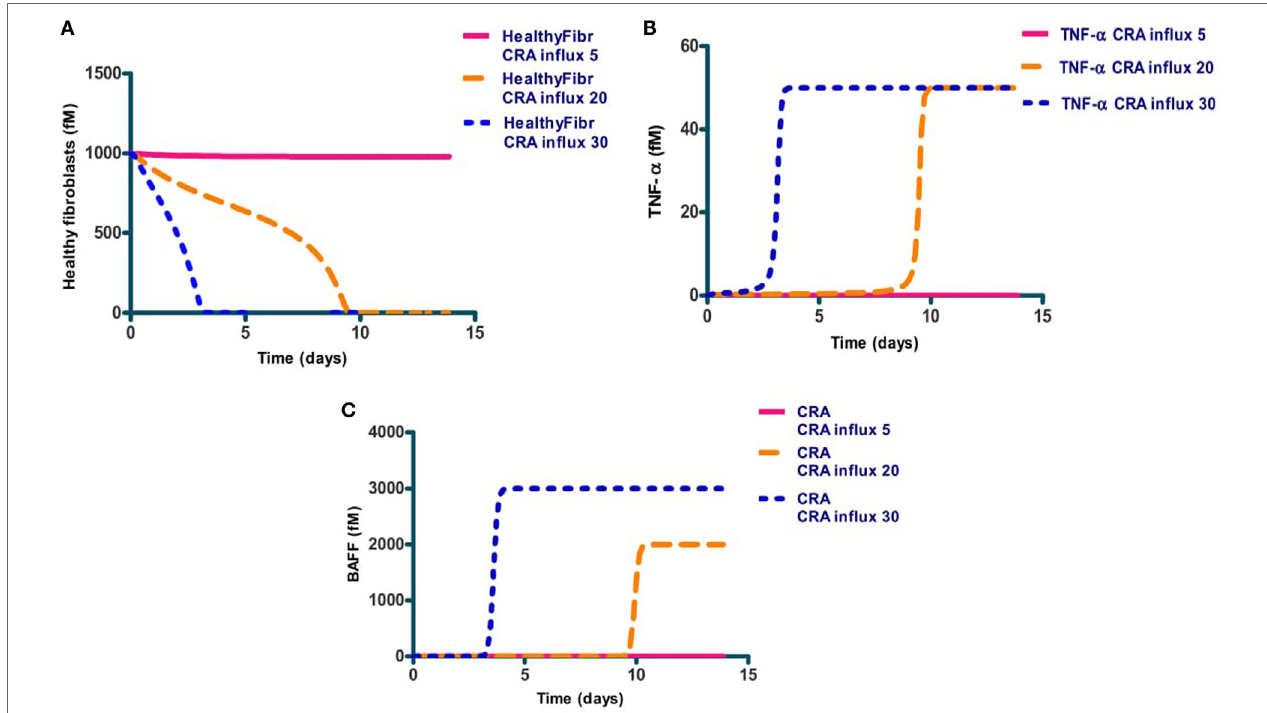
FigUre 3 | The levels of three network components involved in inflammation, i.e., healthy fibroblasts (a) , TNF- α (B) , and antigen (CRA) (c) as functions of time after increasing (at time 0) the CRA influx level. Full line: no increase in CRA influx, i.e., maintained at 5.0 fM/min. Yellow dashed line: CRA influx increased from 5 to 20 fM/min. The blue dotted line: CRA influx increased from 5 to 30